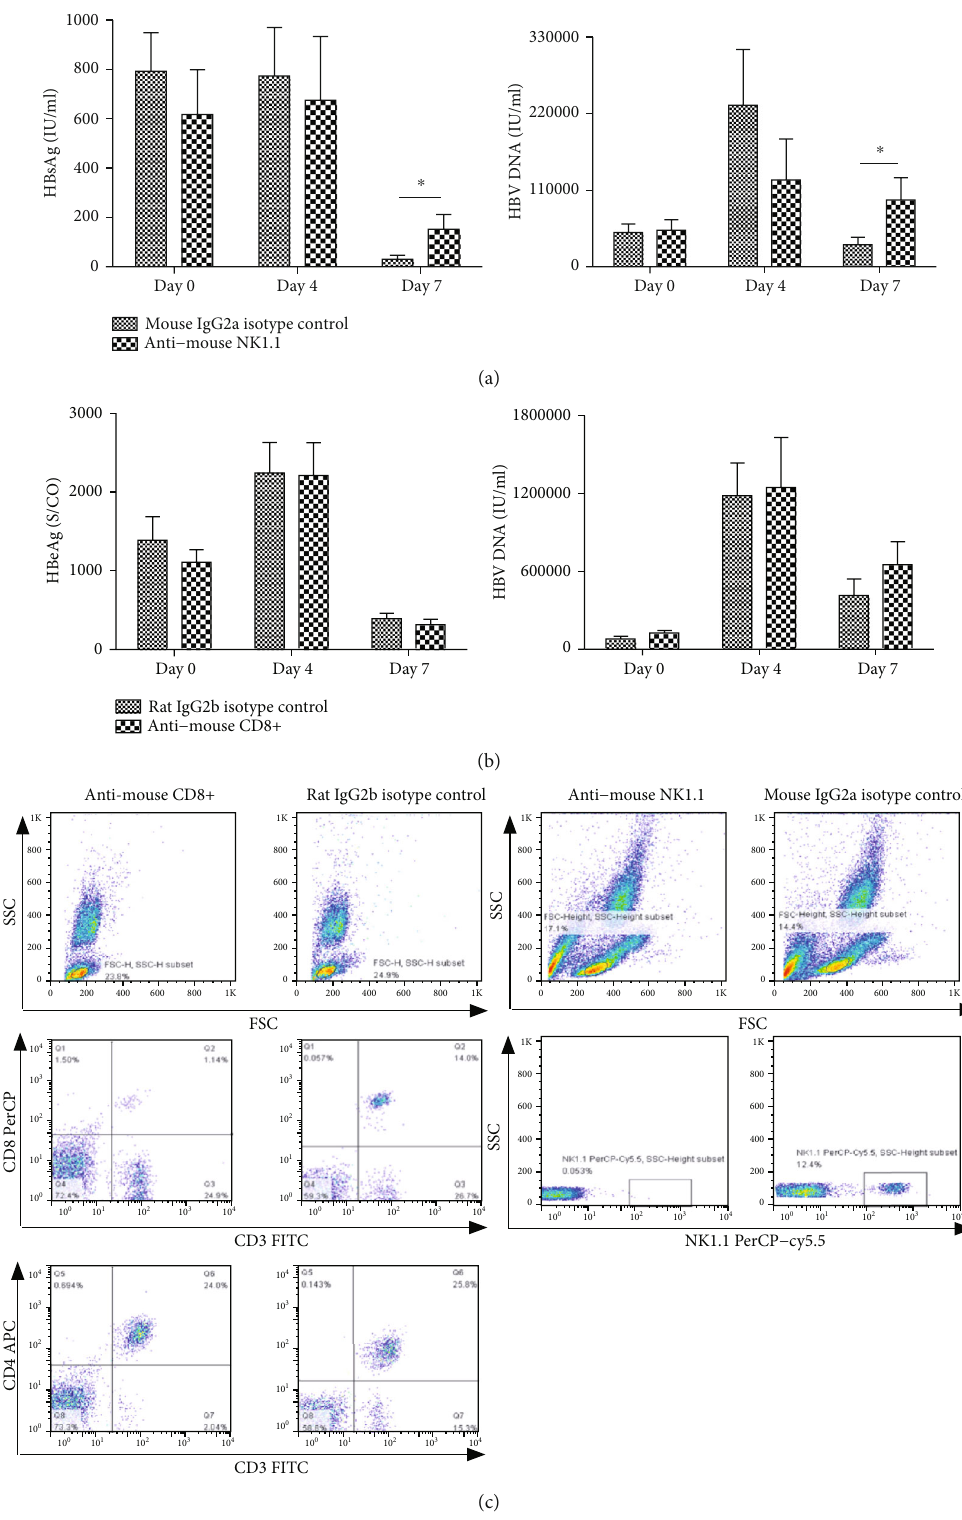
Figure 3: The anti-HBV e ff ect of IL-33 has been impaired in NK depletion HBV mice. After the treatment of IL-33, the levels of HBsAg and HBV DNA in NK depletion HBV mice are higher than its counterparts in WT HBV mice ( P = 0 : 026 and P = 0 : 05 , respectively) (a). However, there is no di ff erence in the levels of serum HBsAg and HBV DNA between the WT HBV mice and CD8+ T cell depletion HBV mice after the treatment of IL-33 (b). The depletion of NK cells and CD8+ T cells was veri fi ed by FACS; compared with their isotype controls, NK cells and CD8+ T cells were almost undetectable (c). The statistical signi fi cance of the data was determined using the Mann – Whitney test; P value is shown in each